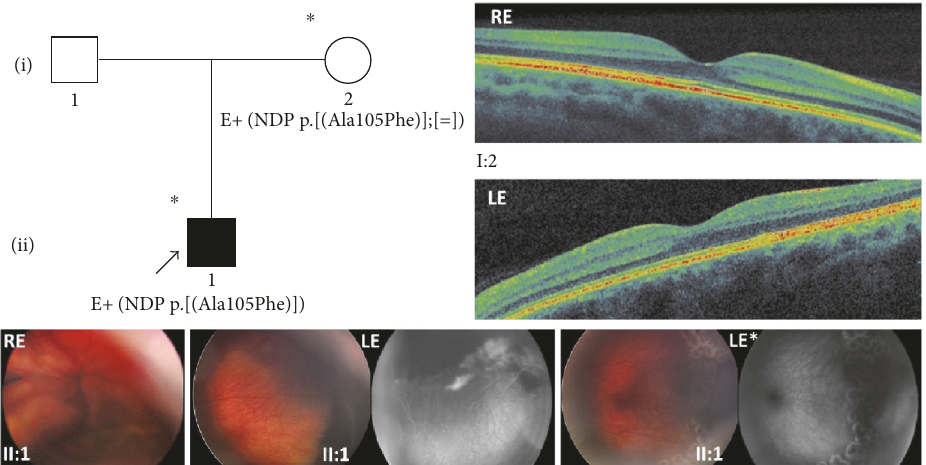
Figure 5: Pedigree and ocular features of family 5. Color fundus photographs by RetCam from the 3 y/o male proband (II:1) of family 5 showing a closed funnel total retinal detachment in the right eye and peripheral exudation with vascular abnormalities before and after laser treatment in the left eye. Fluorescein angiograms performed with RetCam before and after laser treatment showing peripheral ischemic areas with leakage mainly in temporal and inferior peripheral retina in the left eye. Top right, OCT macular scans from the proband ’ s mother (I:2) showing normal retinal features. ∗ Documented clinical evaluation; E+, positive to genetic test; RE, right eye; LE, left eye; LE ∗ , images taken at a subsequent examination after the laser